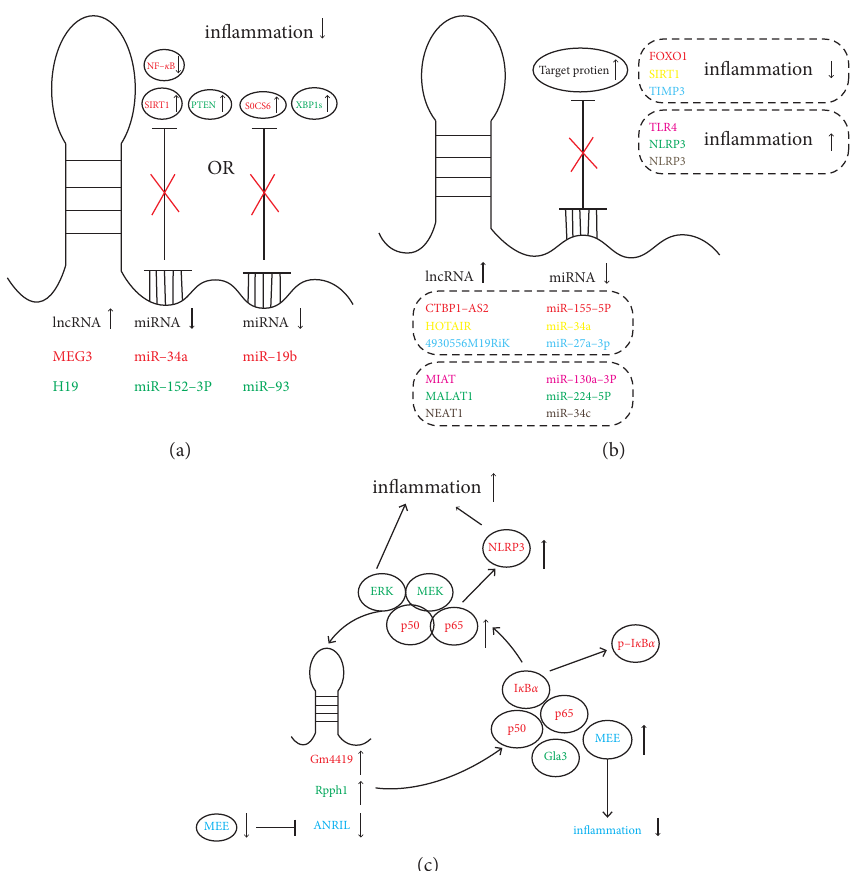
Figure 2: (a, b) The role of lncRNAs as competing endogenous RNAs (ceRNAs). lncRNAs regulate mRNA expression by competing for miRNAs. Influencing target proteins (TLR4, NLRP3, FOXO1, TIMP3, AEGFA, PTEN, and SIRT1) through the NF- κ B, JAK2/STAT3, PI3K/ Akt1, Mek/Erk, and other signaling pathways will eventually lead to the upregulation or downregulation of inflammation. (c) The role of lncRNA interactions with the target protein. Positive or negative feedback regulation eventually leads to upregulated or downregulated